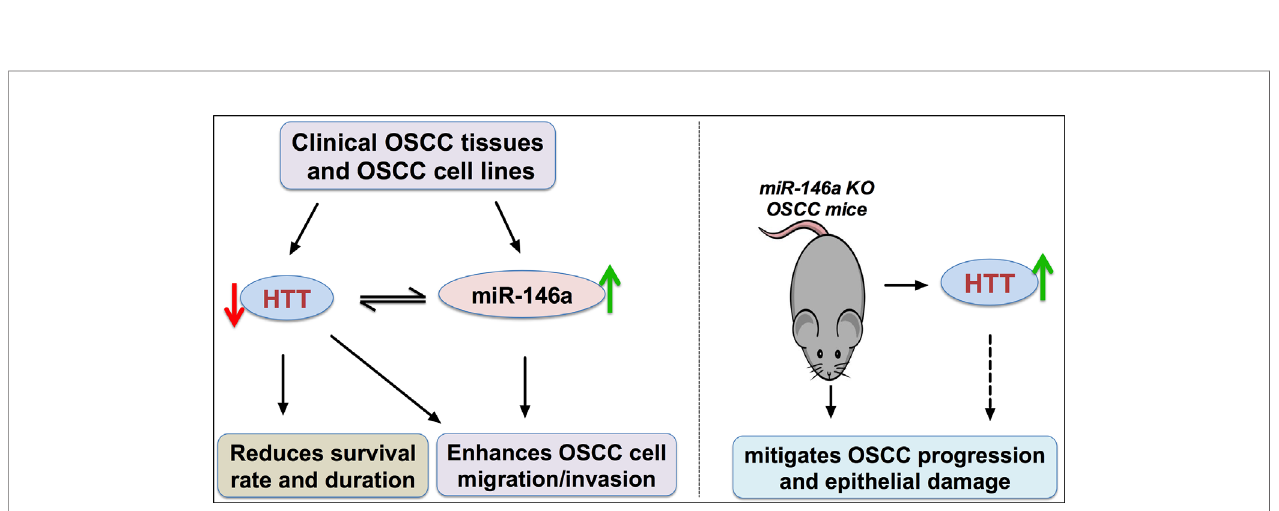
FIGURE 8 | Scheme of miR-146a/HTT axis-mediated possible mechanism of OSCC cell migration and invasion. Red arrow, downregulation; green arrow,